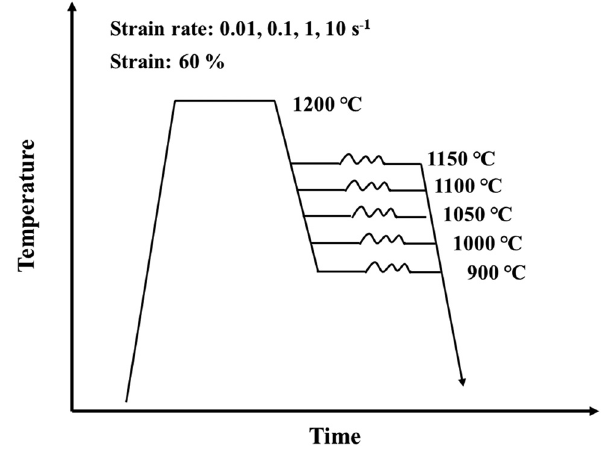
Figure 2: Process fl ow diagram of hot deformation